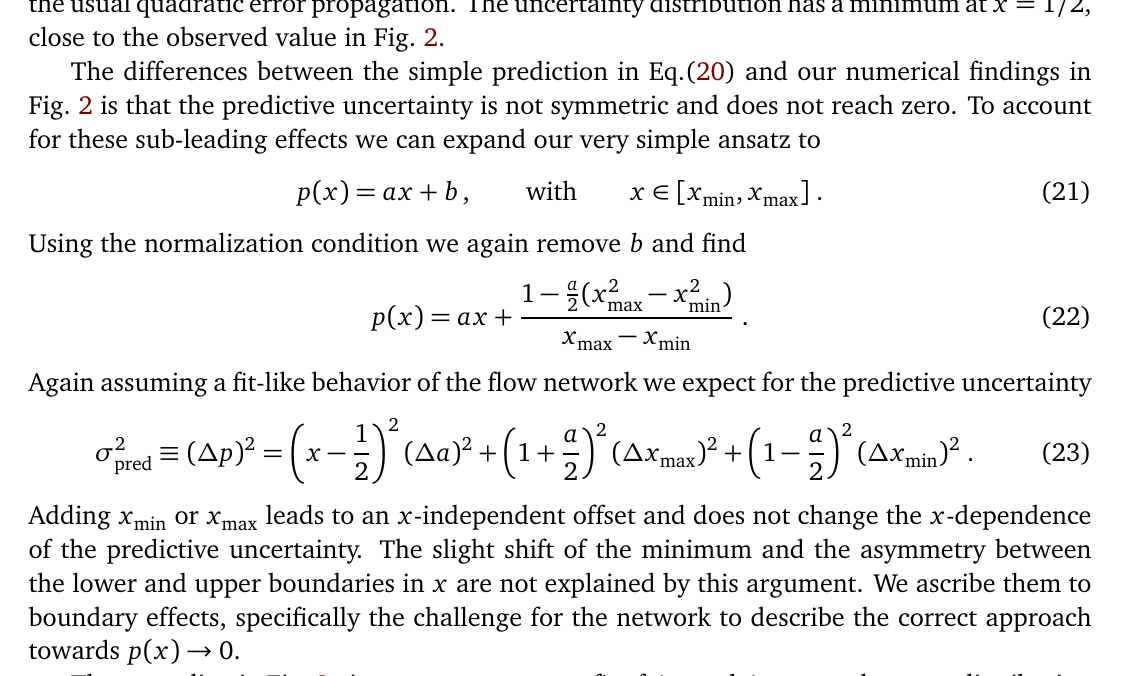
is given by their pred